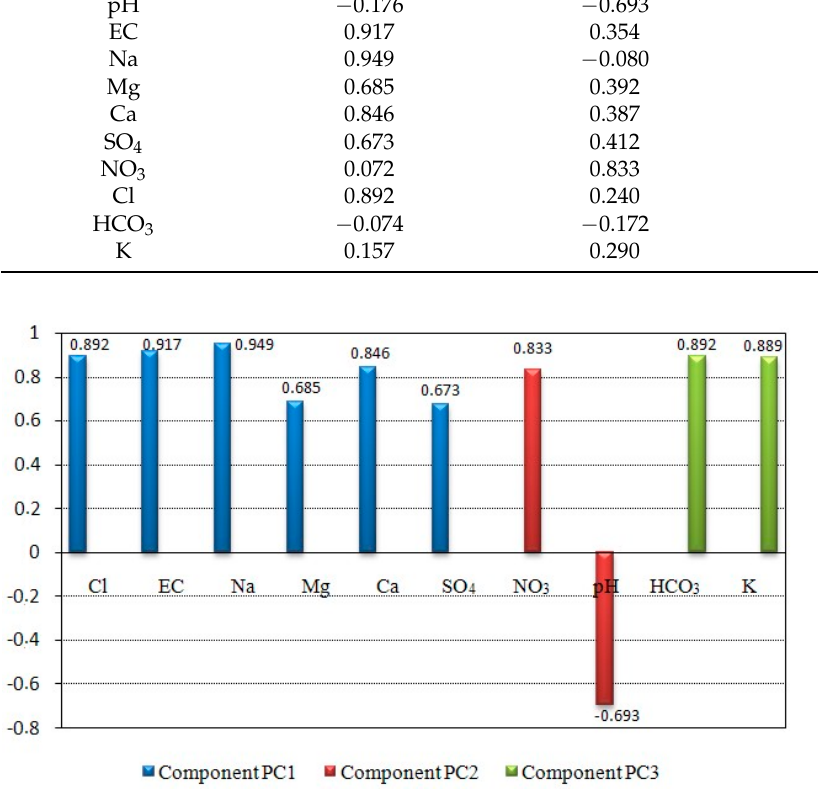
Figure 3. Most relevant PCA result: PC1, PC2, and PC3.